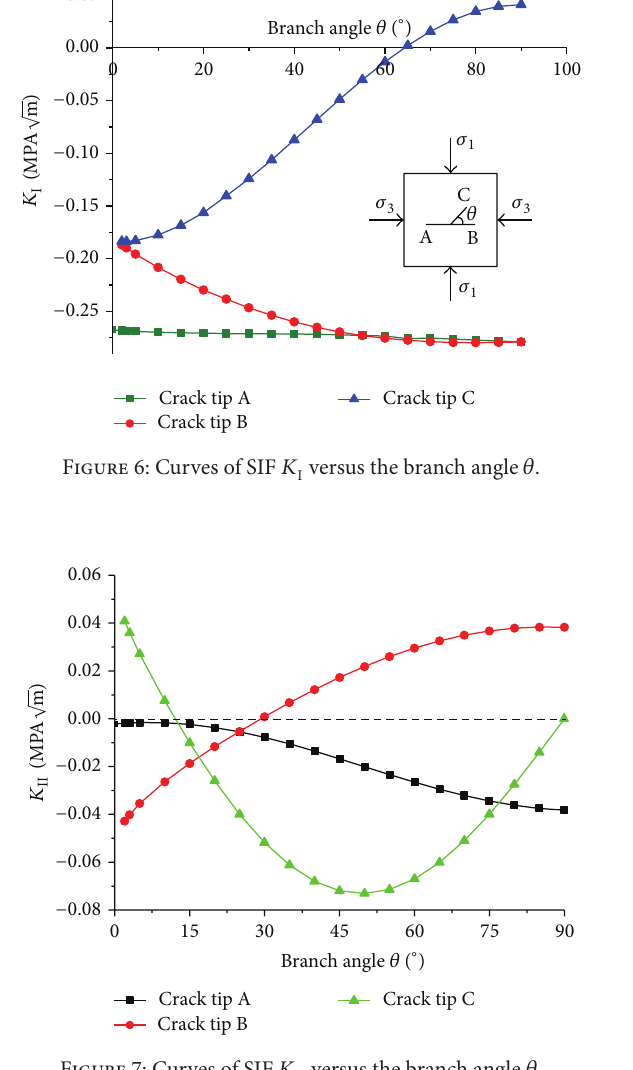
versus the branch angle 𝜃 II